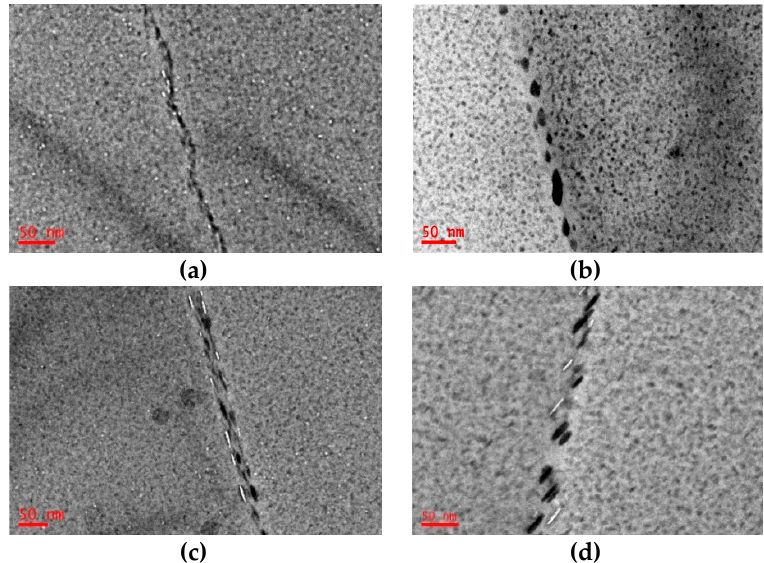
Figure 7. Comparison of the surface and core microstructures after either regular quenching or interrupted quenching: ( a ) surface and ( b ) core of regular quenching and ( c ) surface and ( d ) core of interrupted quenching.